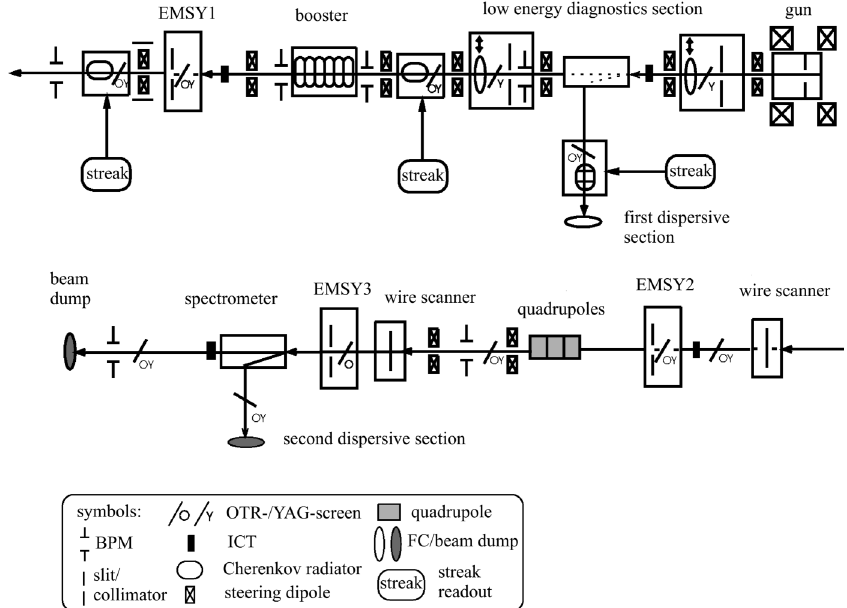
FIG. 1. Schematic diagram of the PITZ-1.6 diagnostics beam line including electron gun, booster cavity, dispersive arms (DISP), optical transition radiation and YAG screens (O/Y), and emittance measurement system (EMSY) stations.